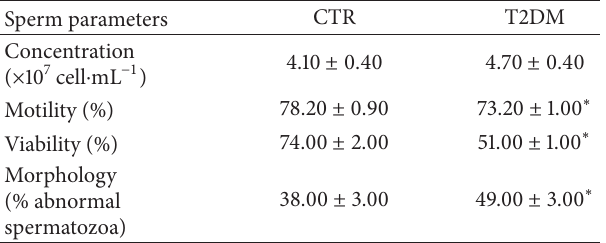
Table 4: Epididymal sperm concentration, motility, viability, and morphology in animals from the control (CTR) and T2DM